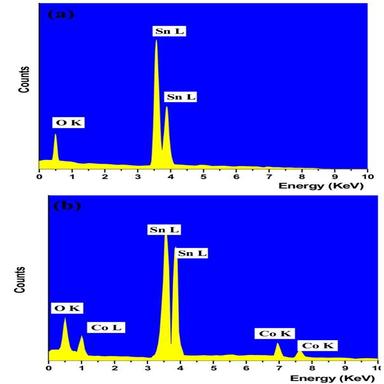
Energy dispersive x-ray spectra of (a) pure SnO2 and (b) 10 at % Co-doped SnO2 nanoparticles.